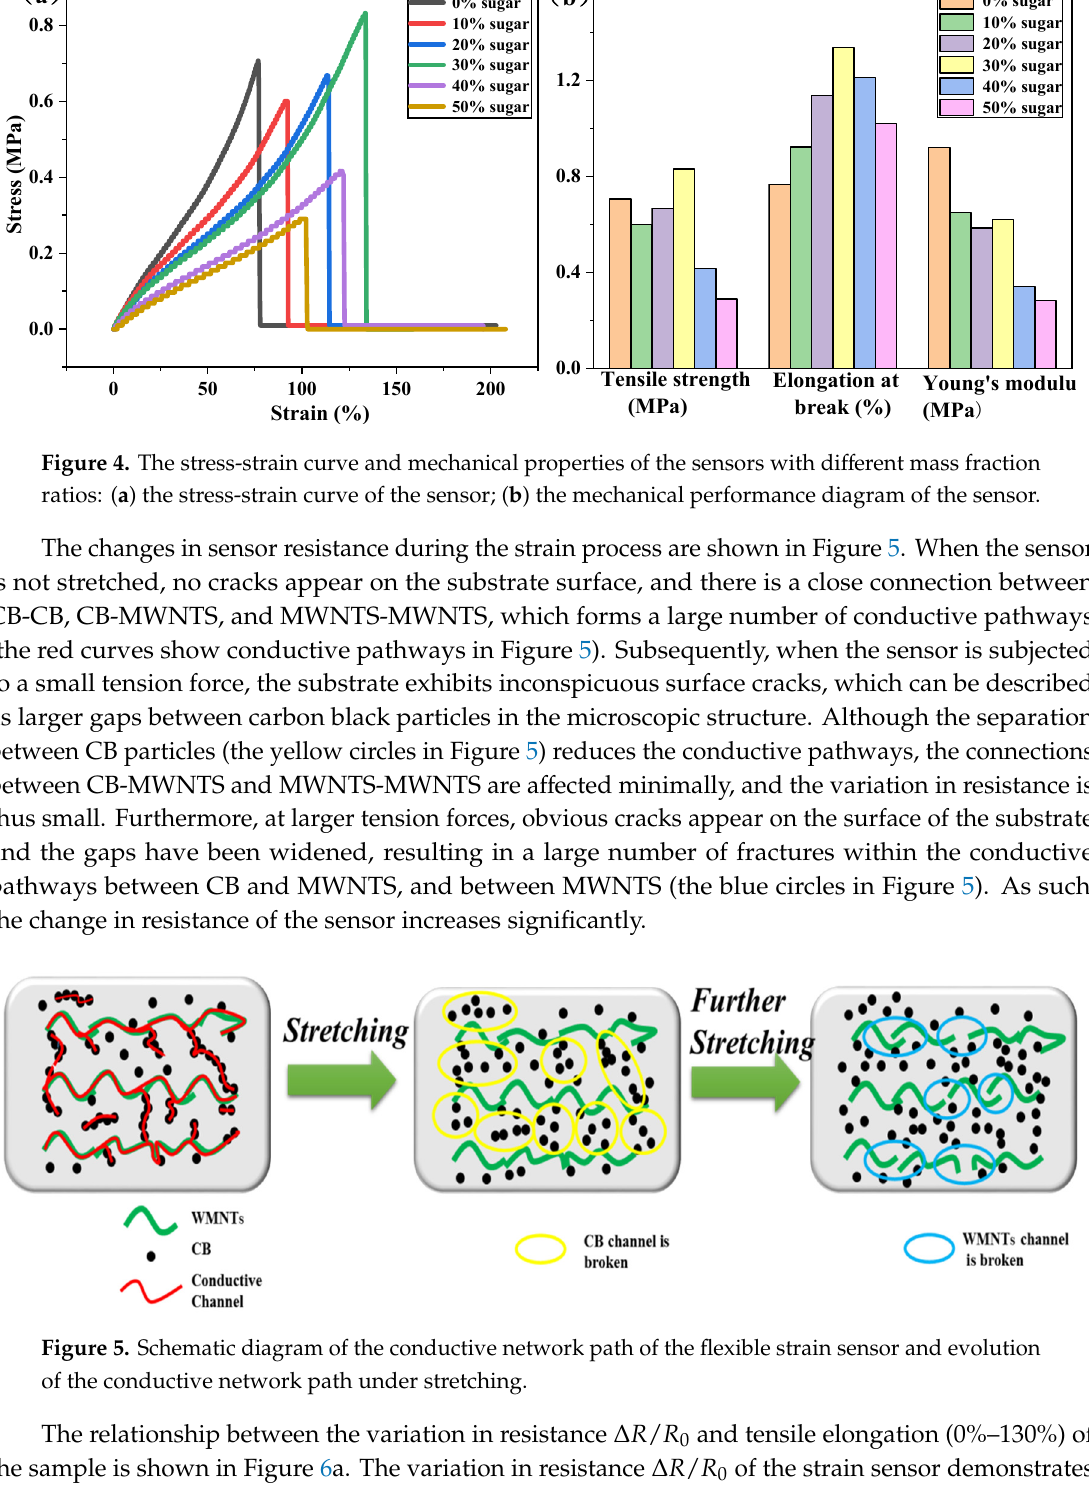
Figure 5. Schematic diagram of the conductive network path of the flexible strain sensor and evolution of the conductive network path under stretching.